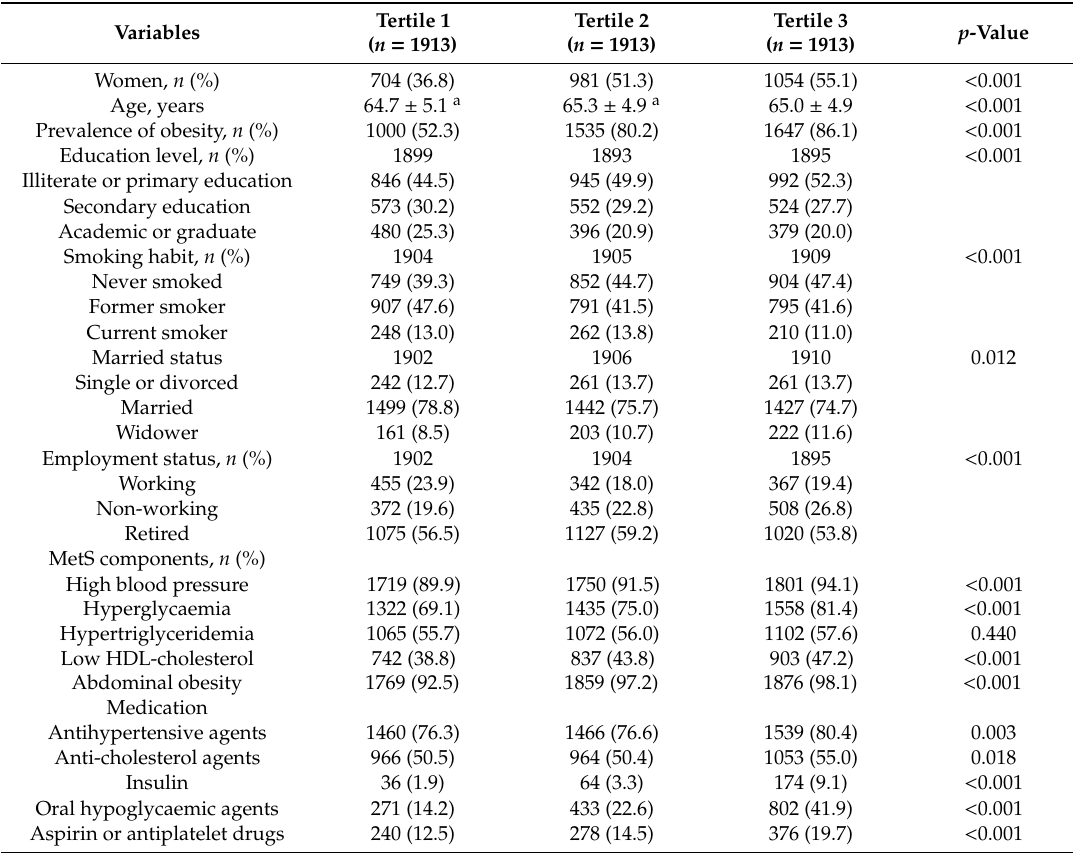
Table 1. Baseline characteristics of participants according to tertiles of the Metabolic Syndrome Severity Score